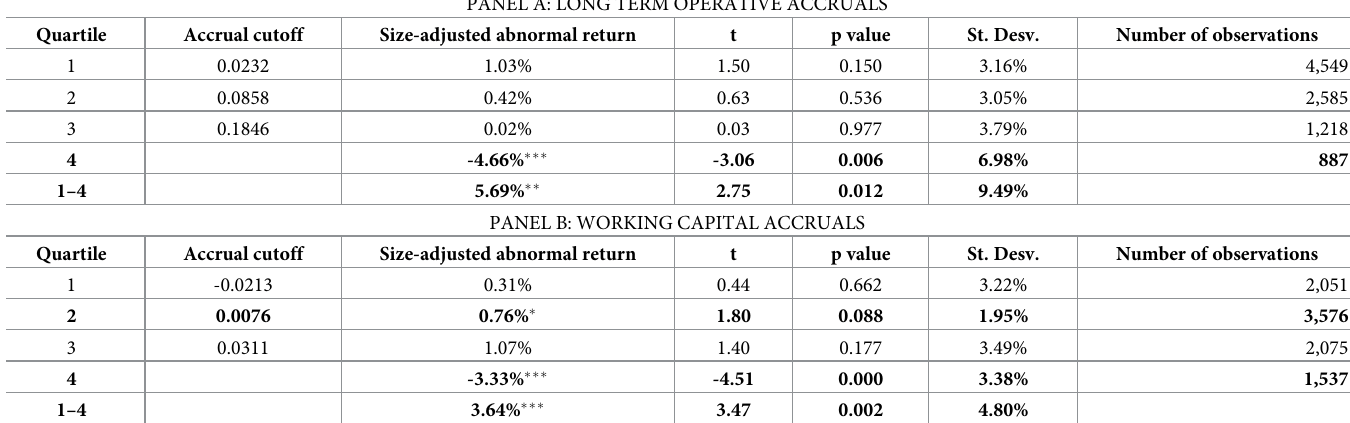
Table 2. Size-adjusted abnormal